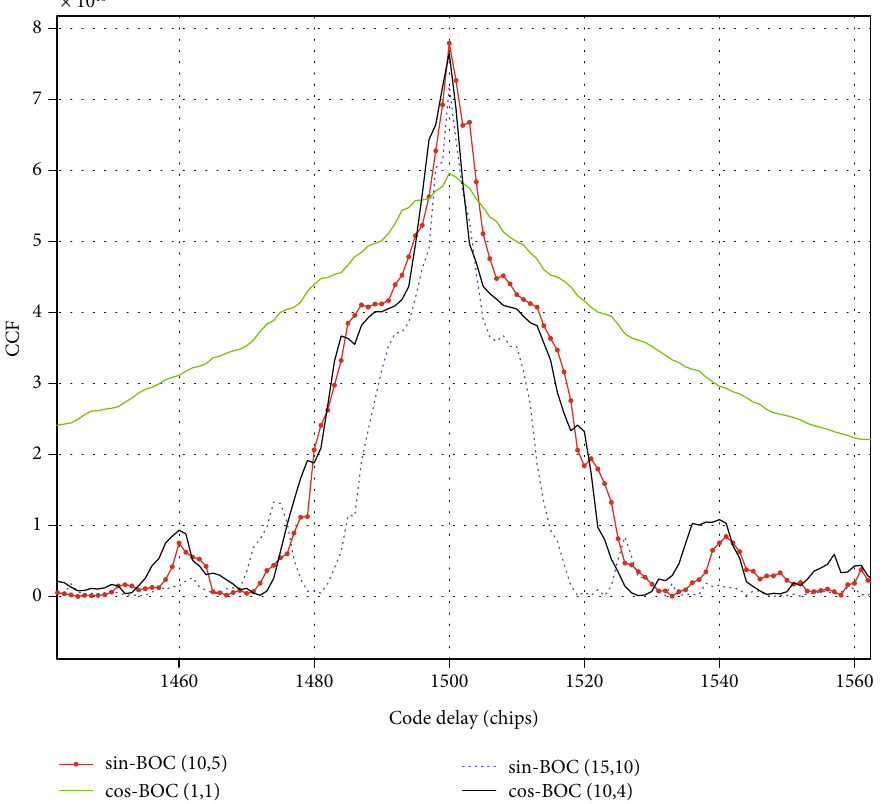
Figure 13: CCF of C / N